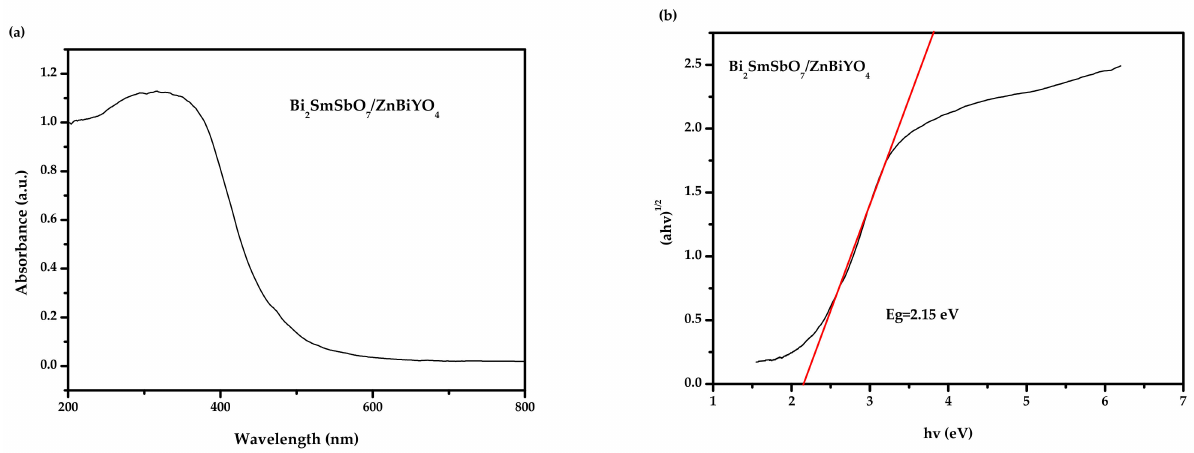
Figure 6. ( a ) The diffused reflection spectrum of Bi 2 SmSbO 7 /ZnBiYO 4 heterojunction; ( b ) Correlative diagram of ( α h ν ) 1/2 and h ν for Bi 2 SmSbO 7 /ZnBiYO 4